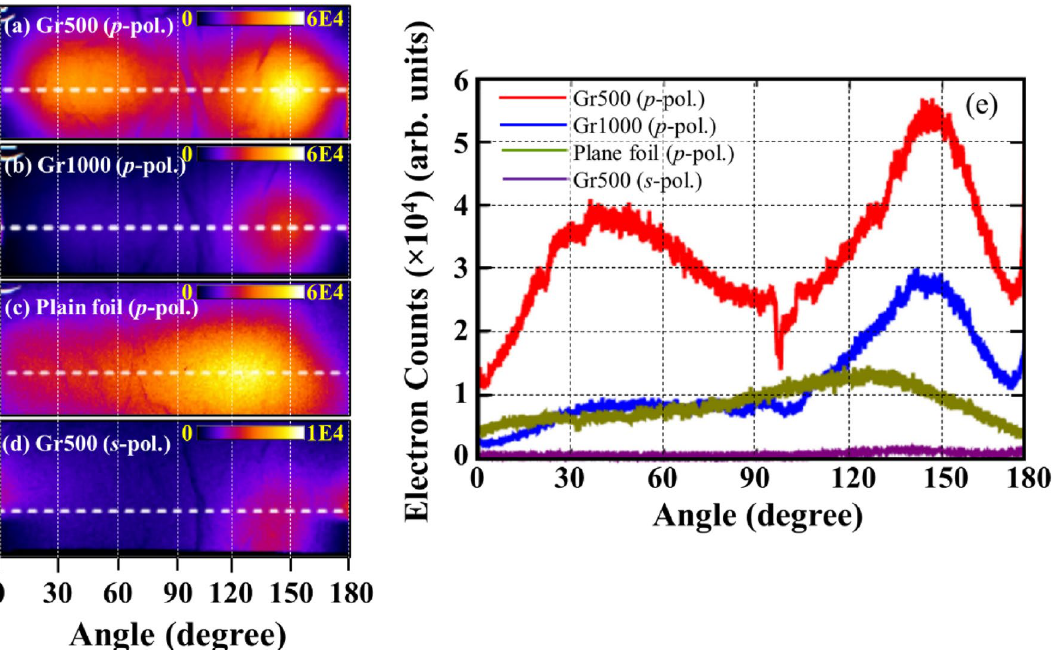
Figure 3. Angular distribution of electrons exiting target is measured with IP. Images of emitted electrons for grating and plane targets for ( a ) Gr500, ( b ) Gr1000, ( c ) plane Au foil, and ( d ) for Gr500 target irradiated by s -polarized laser. ( a ) and ( b ) show the results of single laser shot. ( c ) and ( d ) show results of 5 laser shots integration. ( e ) shows single laser shot line profiles of images for plane, Gr500, and Gr1000 targets- all under p -polarized irradiation, as well as that for Gr500 under s -polarized laser irradiation.